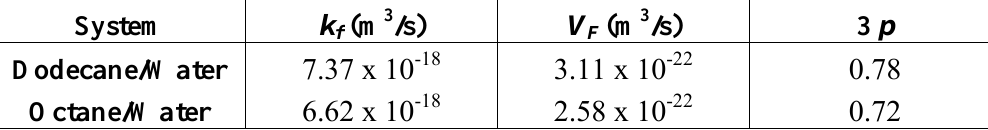
and V ( R = 30 nm, n f F 0